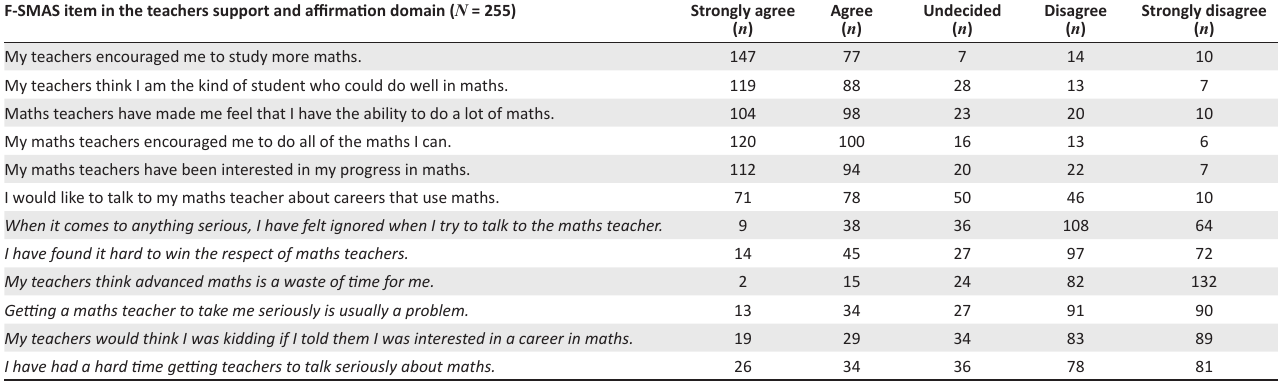
TABLE 8: Number of pre-service teachers selecting each level of agreement on teacher’s support and affirmation domain. F-SMAS item in the teachers support and affirmation domain ( N = 255)